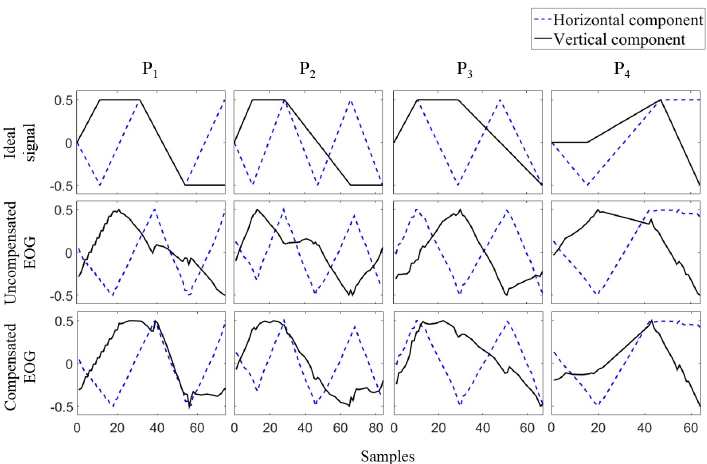
Figure 8. Examples of EOG signals acquired when a subject visually drew four different patterns, where the values were normalized to [ − 0.5, 0.5].